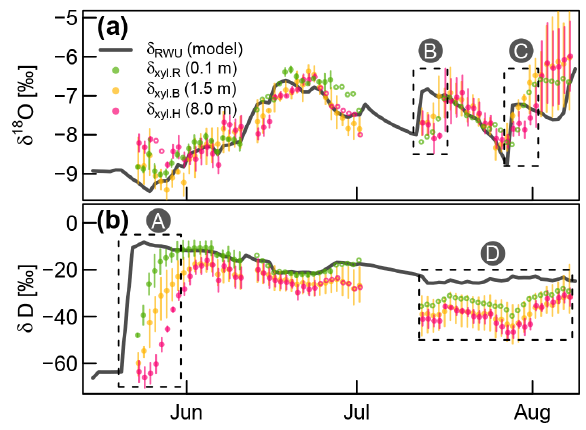
Figure 6. Measured δ xyl (colored dots) compared to the modeled δ RWU (grey line). δ xyl values were averaged across all available probes at each of the three installation heights. Vertical bars indicate the value range of all available (two to three) probes, and empty cir- cles without lines indicate single probe values. Dashed boxes (A), (B) and (C): periods, where observed δ xyl apparently lags behind changes in modeled δ RWU . Dashed box (D): clear bias between modeled δ RWU and measured δ xyl